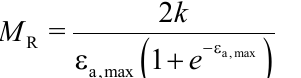
Fig. 3. Main types of rock samples. a-b: megacryst-bearing, medium-grained, biotite- monzogranites, c:medium-grained, biotite-monzogranites with elongated monzonitic enclaves, d: